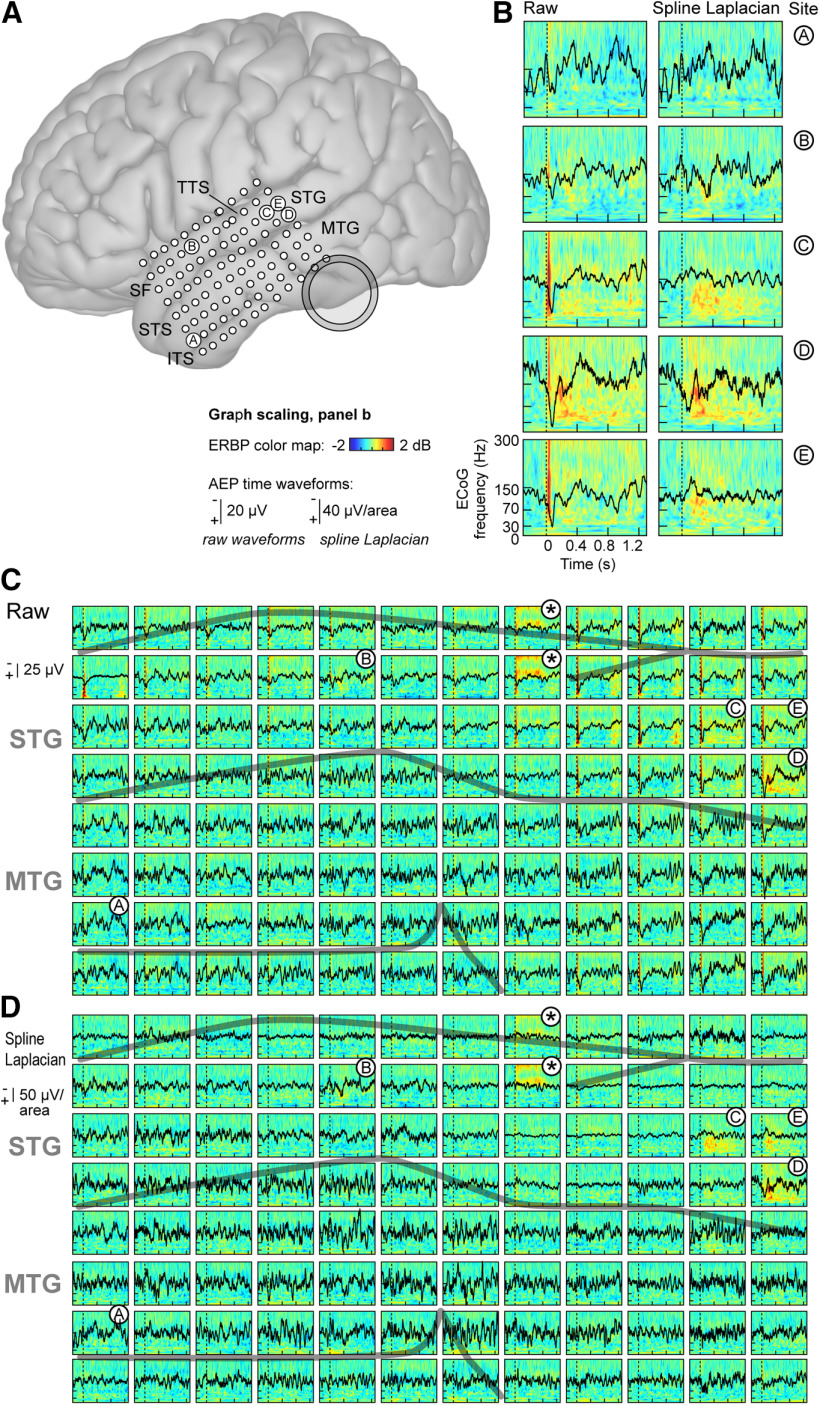
Location of electrode array on brain surface and representative response plots. A, Estimated recording locations of the 96-electrode array as projected onto a template brain surface rendering. Shaded ring indicates the approximate position of the ipsilateral CI receiver. SF: Sylvian fissure; TTS: transverse temporal sulcus, STG: superior temporal gyrus; STS: superior temporal sulcus; MTG: middle temporal gyrus; ITS: inferior temporal sulcus. B, Exemplary data (raw and spline-Laplacian-transformed AEPs and ERBPs) from five recording sites (A–E) are shown for vocalization with auditory feedback via Aux In condition. C, D, Comparison of raw (C) and spline-Laplacian-transformed (D) AEP (black lines) and ERBP (color plots) data for all 96 recording sites for the vocalization with auditory feedback via Aux In condition. Note the very brief, high-amplitude, broadband ERBP response felt to be CI artifact occurring at the time of voice onset (dashed lines) in the raw data that are eliminated by the transform. The artifact is seen at numerous sites but clusters mainly in the superior-posterior quadrant of the array; prominent artifact is also noted at more anterior, non-contiguous sites. Note a different, longer duration high-frequency response at the two sites marked with asterisks; this is also felt to be CI artifact and is not significantly affected by the transform. The transform adds noise to the AEPs for ∼3/4 of the sites but effectively removes the positive component beginning at time 0 in the posterior-most contacts. Gray lines indicate major sulci. Axes in C, D are scaled as they are in B.